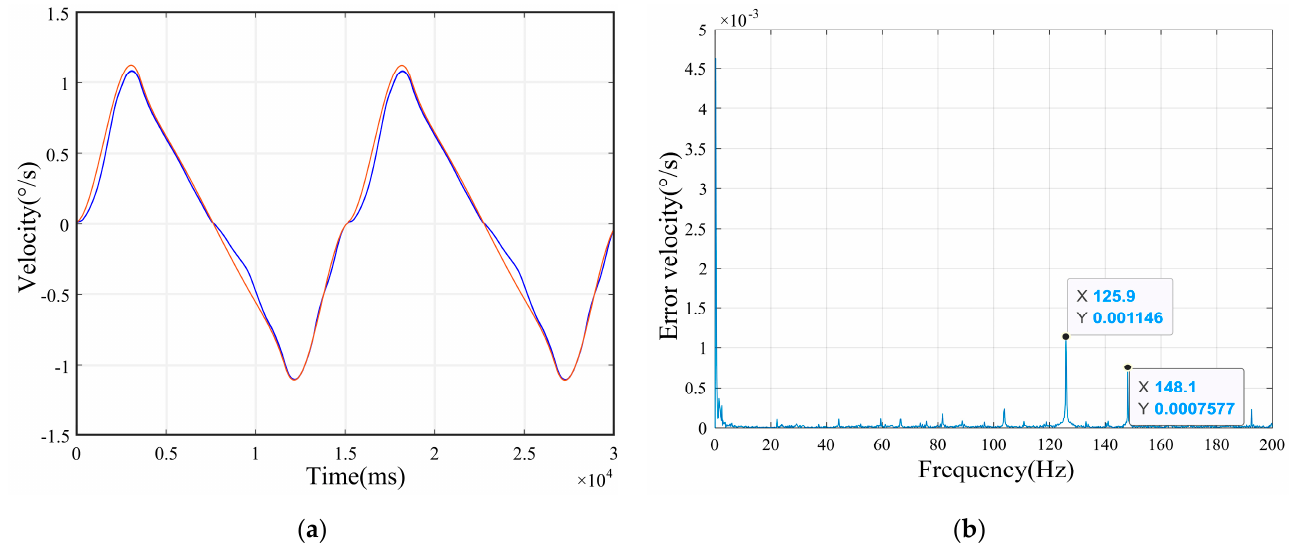
Figure 5. Ground platform test data. ( a ) Ground tracking velocity test curves, ( b ) The error of Figure 5. Groundplatformtestdata. ( a )Groundtrackingvelocitytestcurves,( b )Theerrorofvelocity image. velocity image.